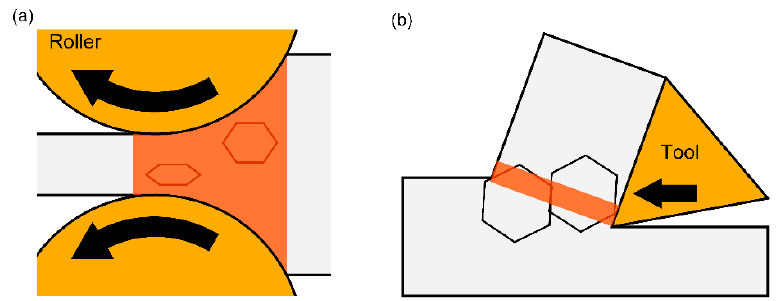
Figure 7. Plastic deformation zone of ( a ) rolling and ( b ) cutting against grain size.